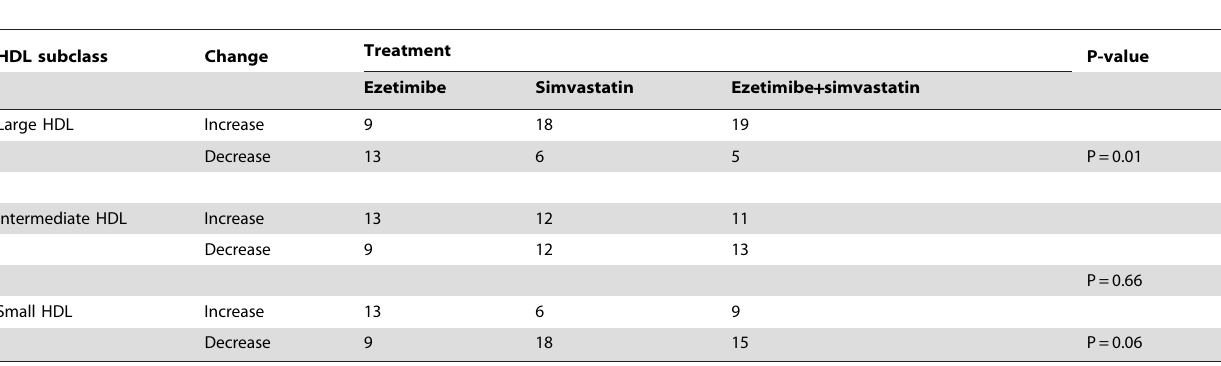
Table 4. Effects of ezetimibe, simvastatin or the combination treatment on the number of subjects with an increase or decrease in HDL